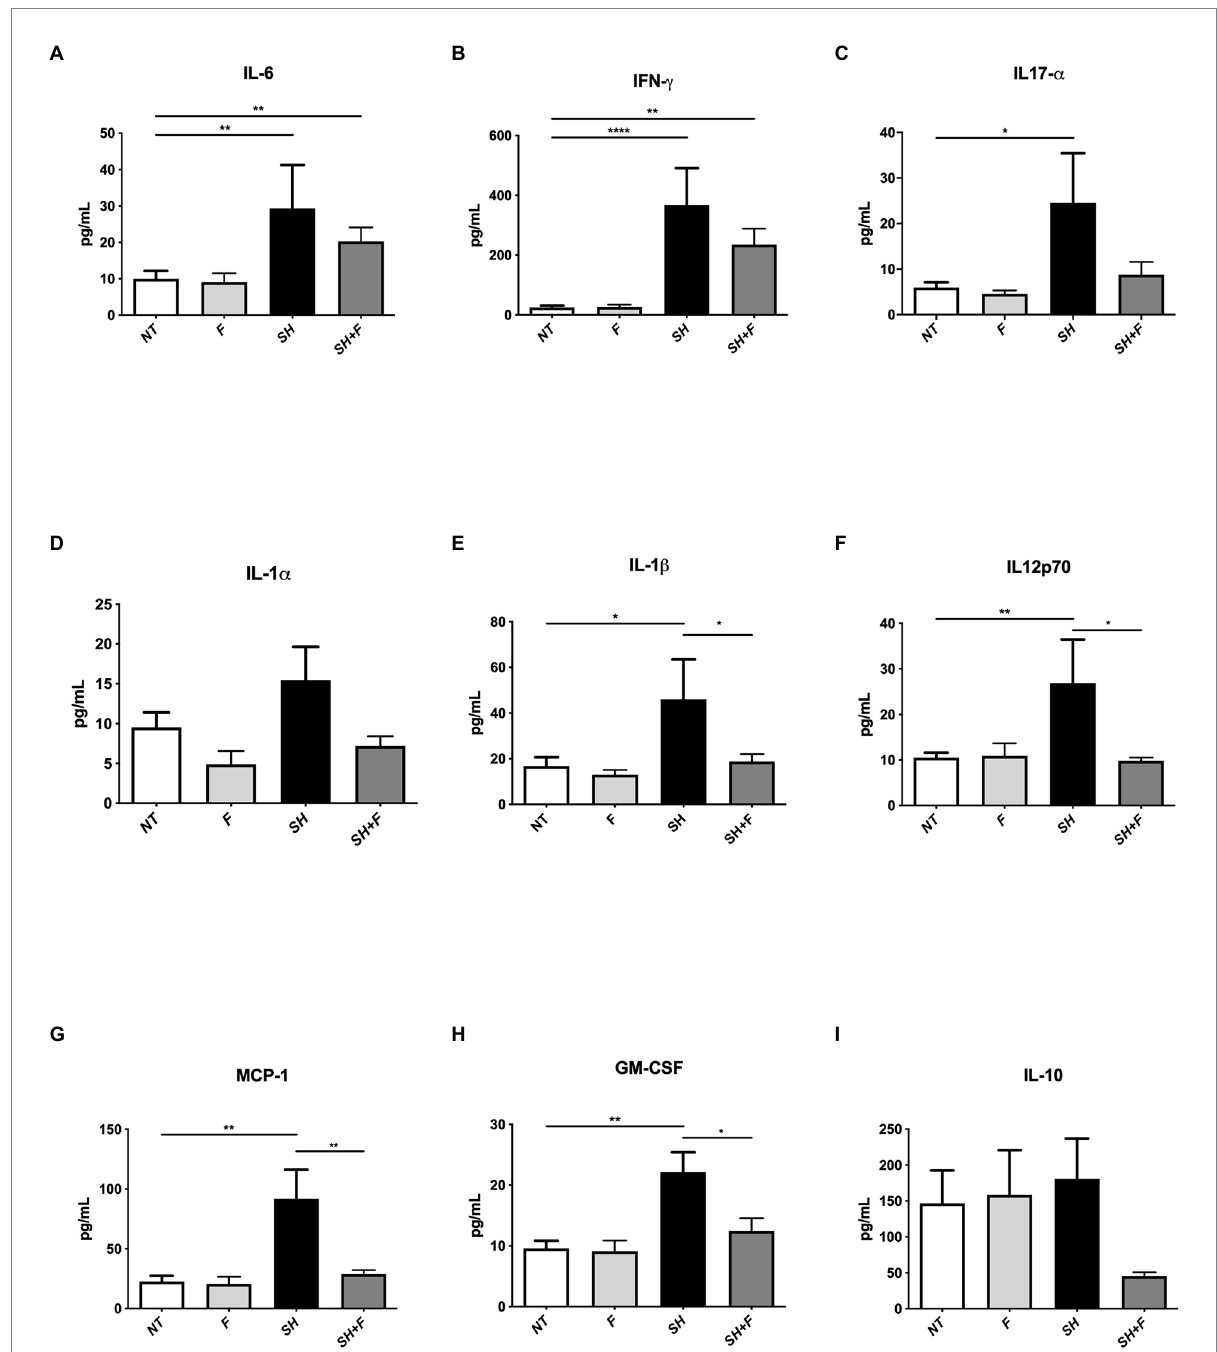
FIGURE 4 Bioactive fractions attenuated systemic cytokines during Salmonella Heidelberg infection. The concentration of inflammatory cytokines in mice plasma was measured using a Legendplex mouse inflammatory panel composed of a magnetic bead panel. The concentration of IL-6 (A) , IFN- γ (B) , IL17- α (C) , IL-1 α (D) , IL-1 β (E) , IL12p70 (F) , MCP-1 (G) , GM-CSF (H) , and IL-10 (I) are indicated. Normality of data was verified by Shapiro test. ANOVA one way was used for n = 5. All data were presented as means (SEM). * p < 0.05; ** p < 0.01; *** p < 0.001; **** p <